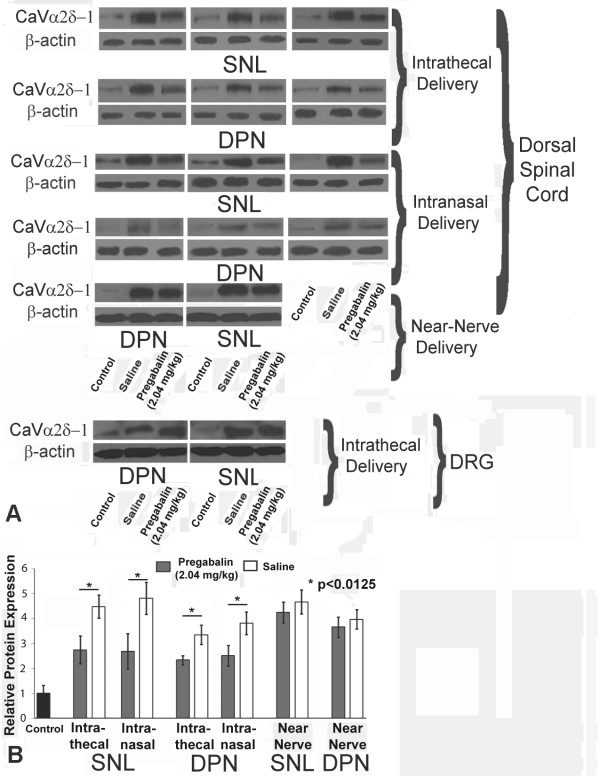
Protein Quantification. Western blotting identified increased levels of CaVα2δ-1 protein in the dorsal horn and lumbar DRGs for rats exposed to either diabetic peripheral neuropathy (DPN) or spinal nerve ligation (SNL) when compared to control rats (A). In the dorsal spinal cord, either intrathecal or intranasal delivery of high dose (2.04 mg/kg/d) pregabalin was associated with less upregulation of CaVα2δ-1 protein than with saline delivery (B). The near nerve delivery of pregabalin failed to impact upon CaVα2δ-1 protein expression in the dorsal spinal cord following SNL or DPN (A, B). Finally, pregabalin delivered in any manner was not associated with impact upon CaVα2δ-1 protein expression in the lumbar DRGs exposed to either DPN or SNL when compared to saline delivery (intrathecal delivery results shown) (A). Multiple unmatched ANOVA tests were performed between cohorts receiving pregabalin and saline for each intervention and condition, with * indicating significant difference (p < 0.0125 after Bonferroni corrections) between cohorts. β-actin protein levels were used for quantification of ratios of CaVα2δ-1/β-actin demonstrated in B.